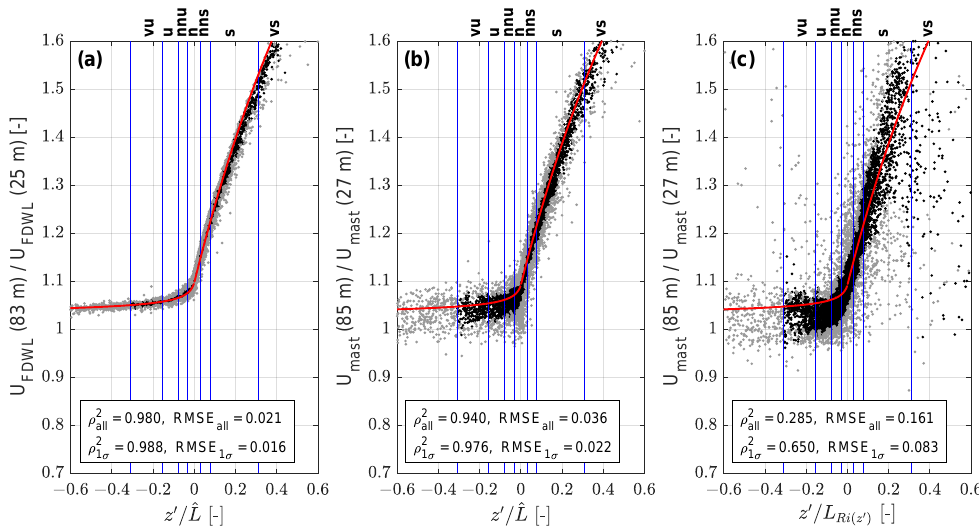
Figure 9. ( a , b ) The FDWL and mast wind-speed ratios as a function of z (cid:48) , respectively. ( c ) The mast ˆ L wind-speed ratio plotted as a function of z (cid:48) . Black and grey dots represent valid and outlier samples, L Ri respectively. z (cid:48) = 15.5 m. ρ is the coefficient of determination. Subscripts “all” and “1 σ ” represent